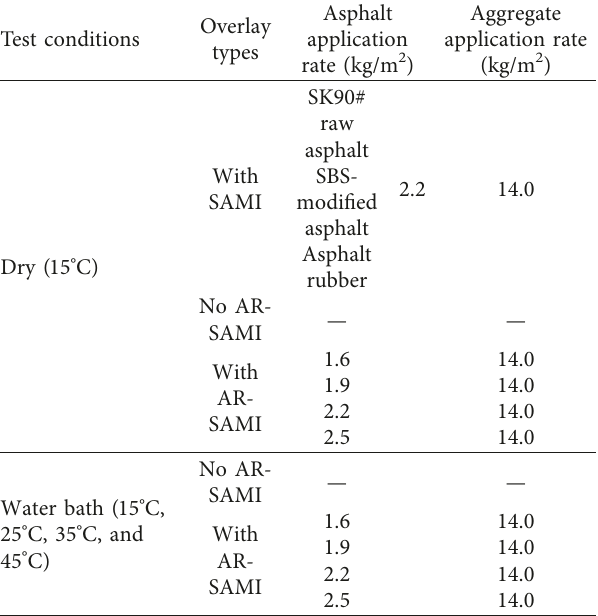
Table 6: The test conditions and programs of the fatigue cracking